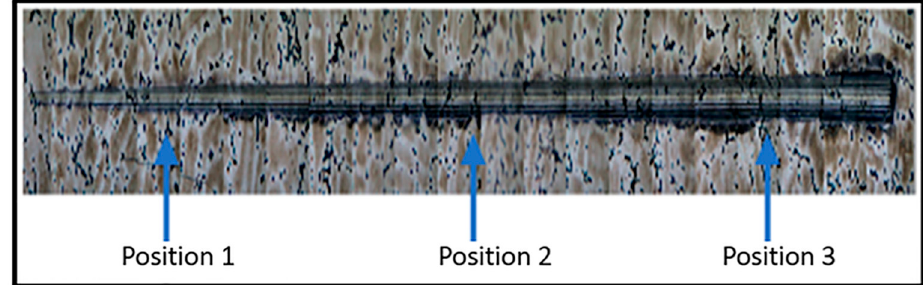
Figure 5e. The theoretical model was used to calculate the f ab material removal factor, as described previously [52,53]. In Equation (6), A v is the area of a wear groove, measured using a cross-section through the groove, and (A 1 + A 2 ) is the area of the material pushed to the groove edges via plastic deformation. It follows from this definition that ideal mi- croploughing results in f ab = 0 (with all the groove material being pushed to the sides) and ideal microcutting in f ab = 1 (with the material being chipped out). Microcracking only occurs on brittle materials and leads to f ab > 1 [23].